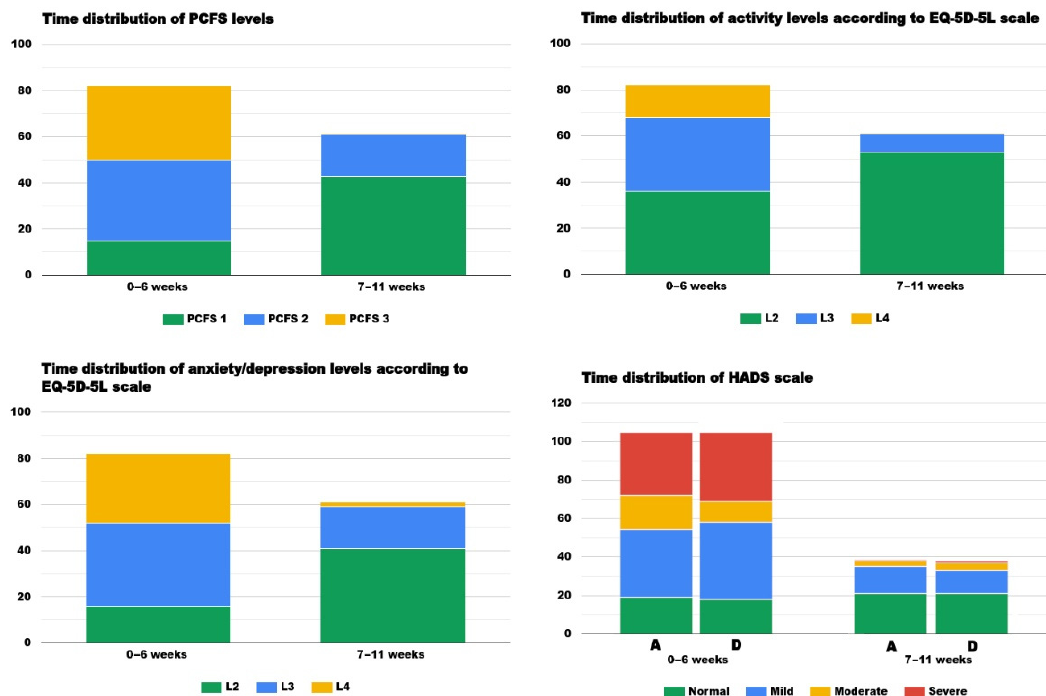
Figure 2. Time distribution of the results of the PCFS, EQ-5D-5L, and HADS scales evidencing that patients assessed in the first 6 weeks after the COVID-19 diagnosis had worse levels of PCFS, a lower level of activity, and reported more severe symptoms of anxiety and depression in comparison to those evaluated after 7 to 11 weeks of recovery.